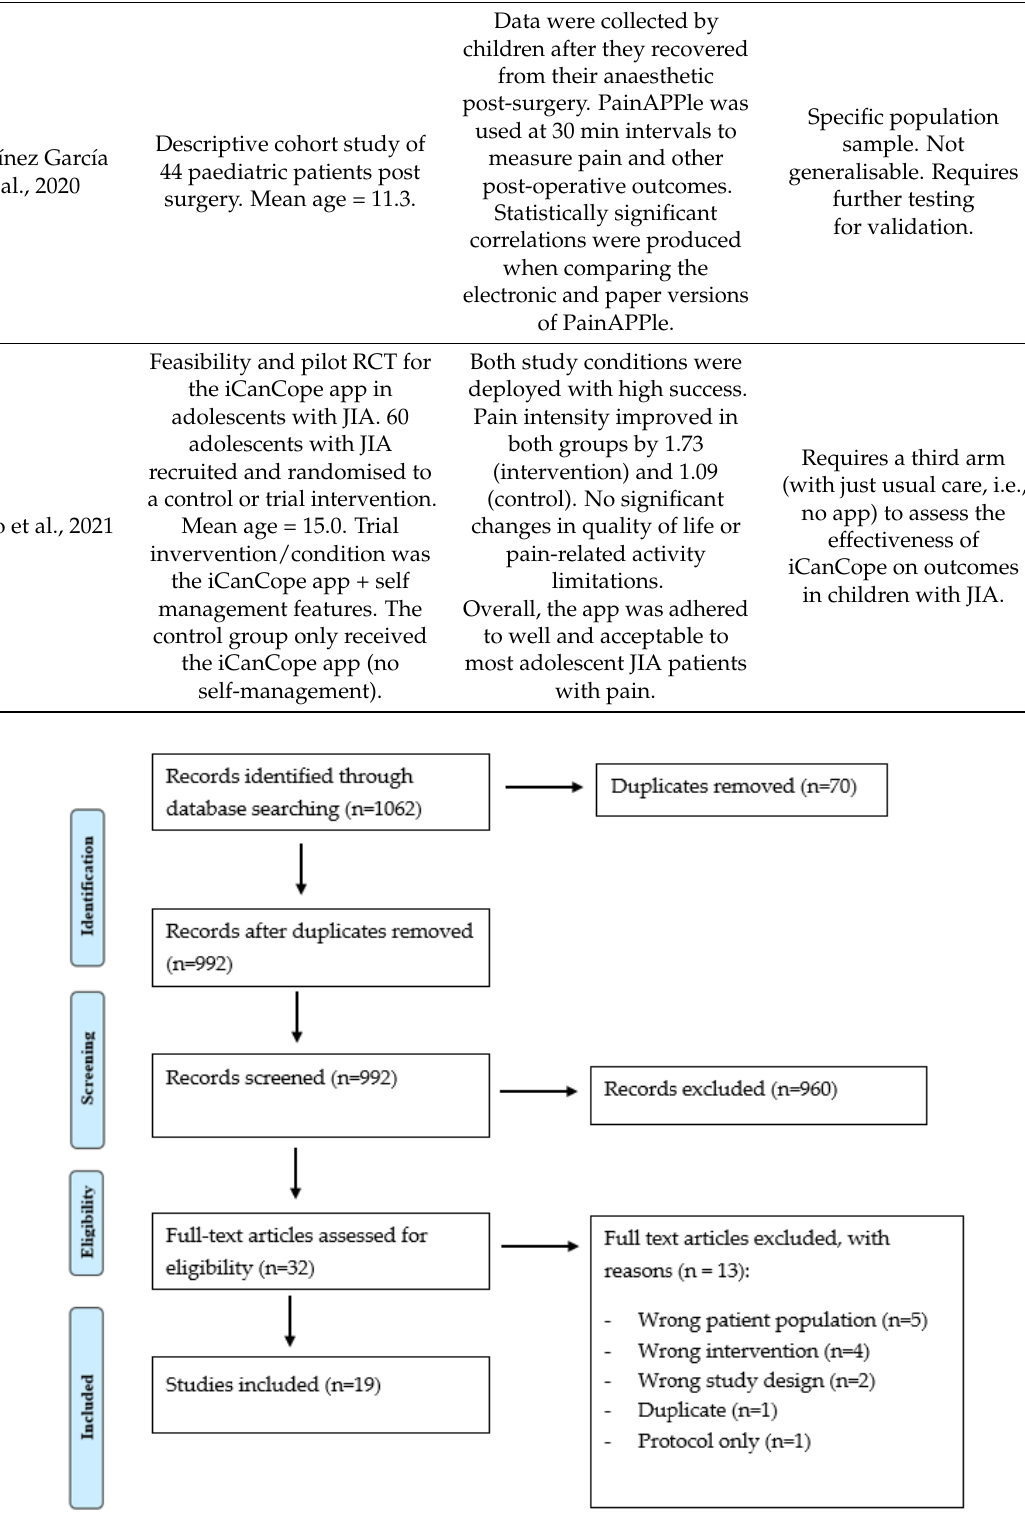
Figure 1. PRIMA flow chart. Table 3. Summary of findings and limitations of emerging pain outcome measures included.